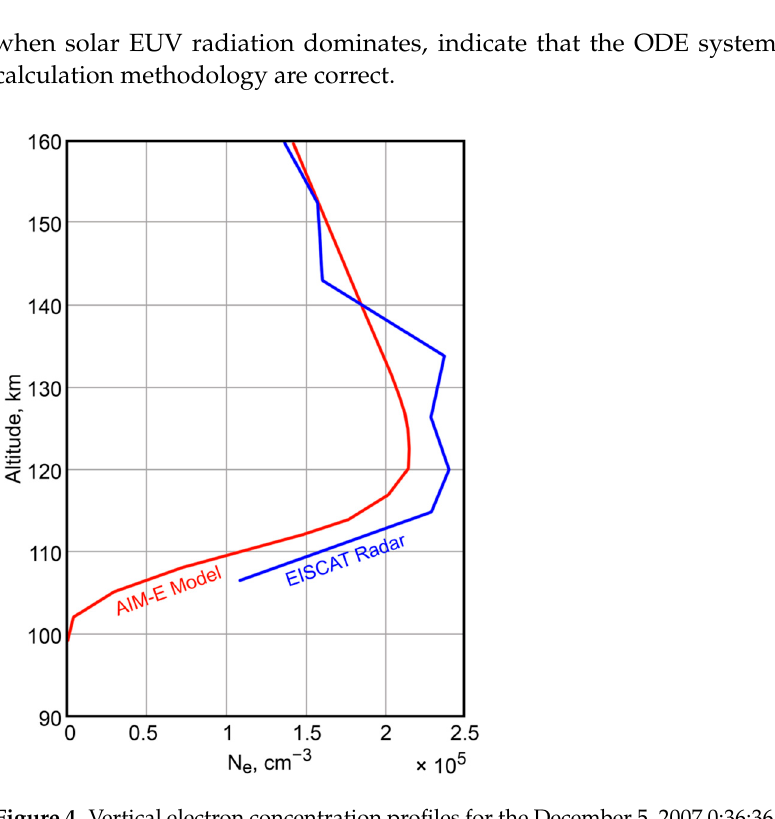
Figure 4. Vertical electron concentration profiles for the December 5, 2007 0:36:36 UT (0.610 h). AIM-E model electron concentration—red line and EISCAT UHF incoherent scattering radar—blue line.